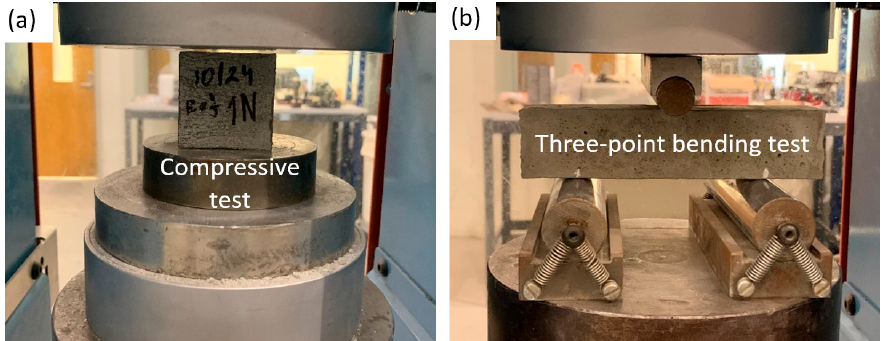
Figure 3. Experimental setup for the ( a ) compressive and ( b ) three-point bending tests (all scale bars are 20 mm).